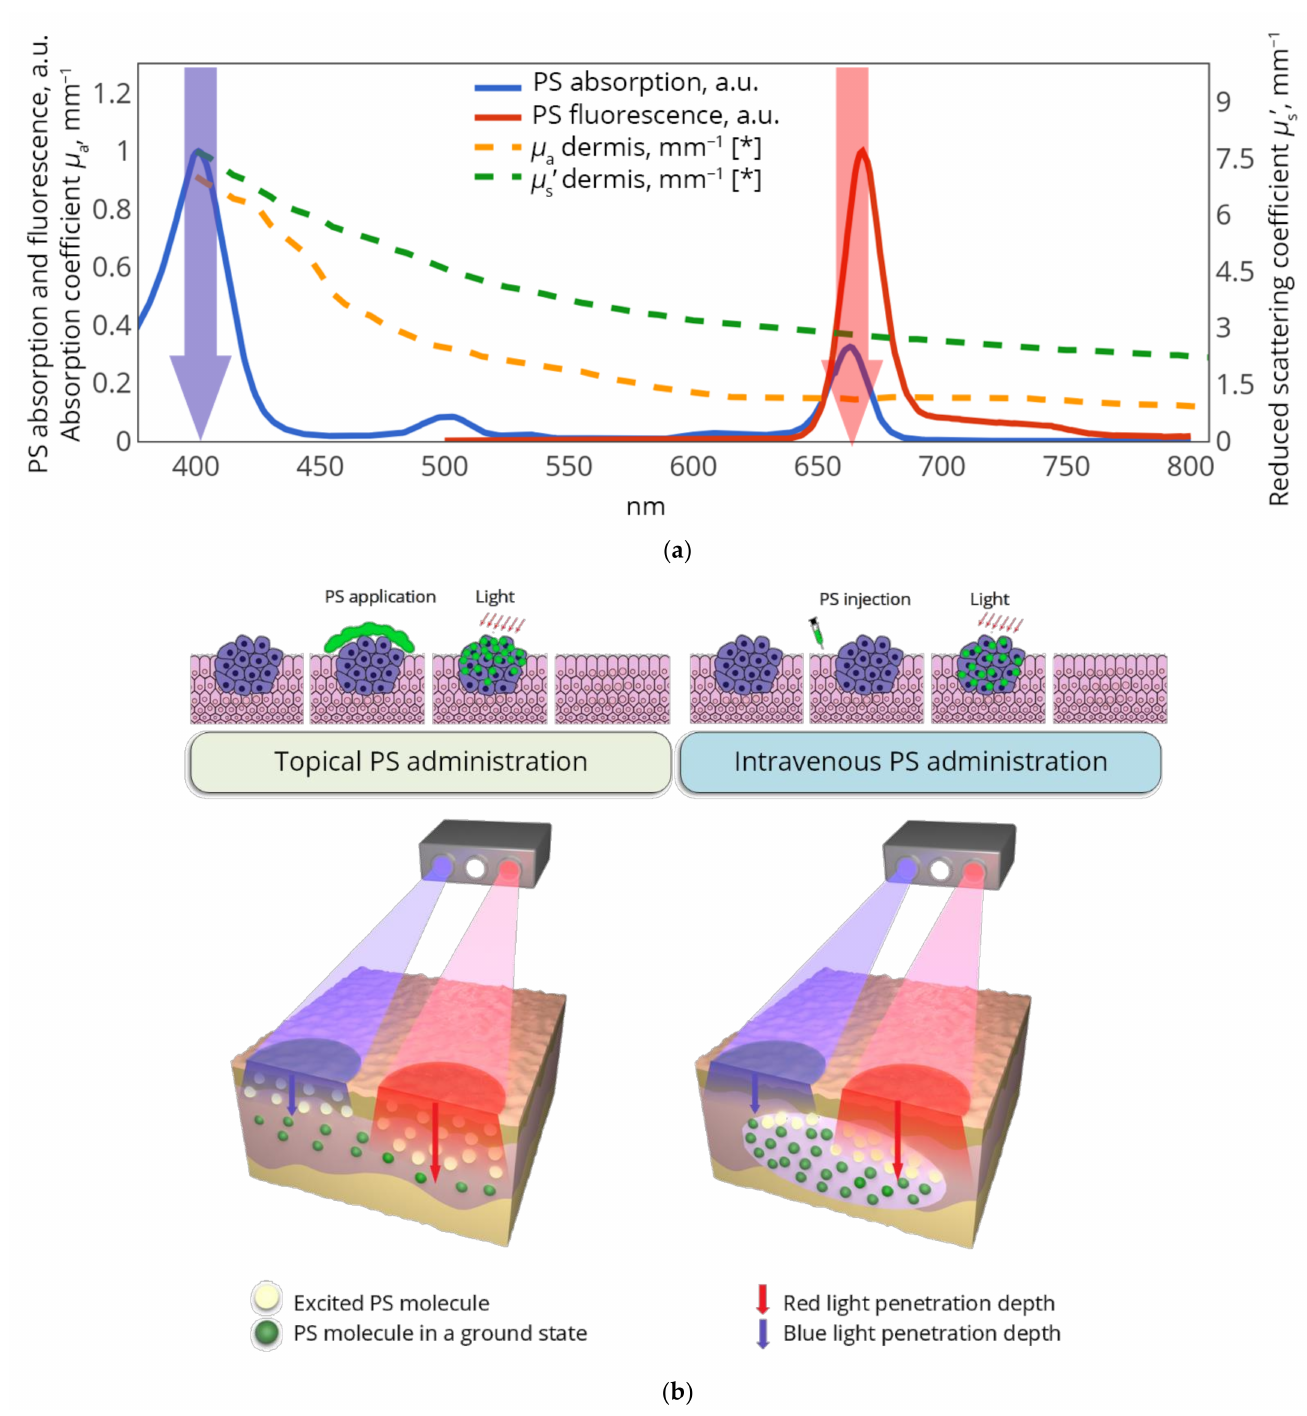
Figure 1. Dual-wavelength fluorescence imaging with chlorin e6 based photosensitizers. ( a ) Absorption and fluorescence spectra of chlorin e6-based PS and typical spectra of scattering and absorption coefficients of human dermis (*adopted from Salomatina et al. [23]); arrows show fluorescence excitation wavelengths employed in the proposed dual-wavelength imaging; ( b ) principles of FI with dual-wavelength excitation for topical PS administration (left) and intravenous PS injection